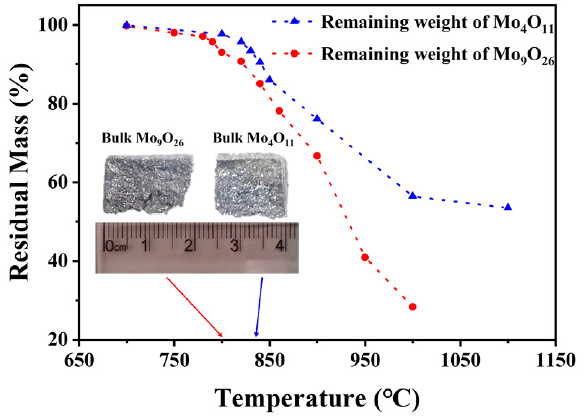
Figure 3. Residual mass of substoichiometric molybdenum oxides after heat treatment.